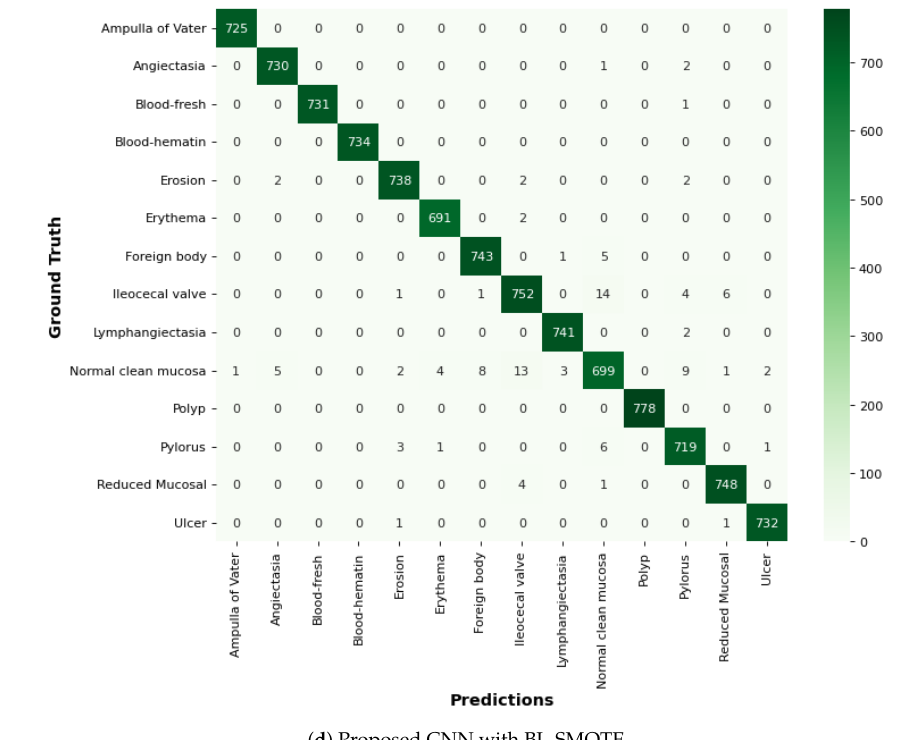
Figure 15. Comparison of the proposed model using confusion matrix.